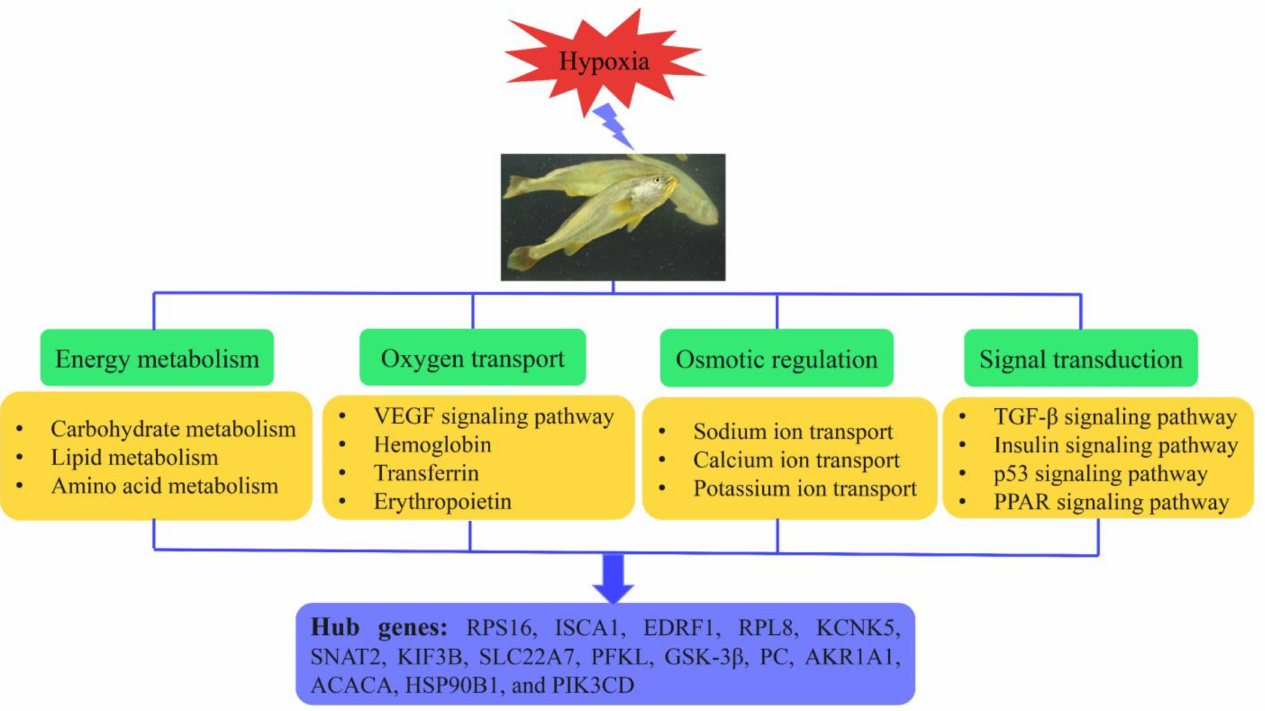
Figure 8. Diagram of hypoxia adaptation strategies and regulatory hub genes in L. crocea . See text for abbreviations and explanations.